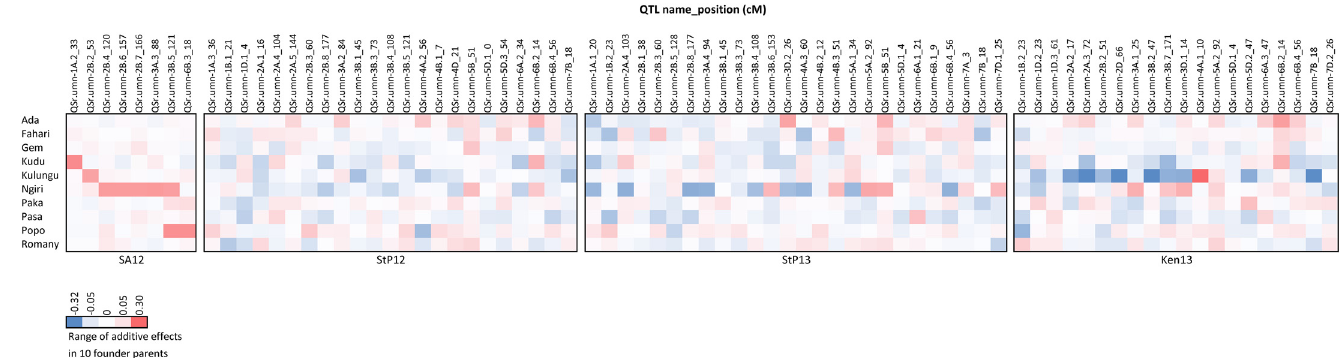
Fig 5. Heat map of additive effect estimates of alleles contributed by the 10 founder lines at the QTL for resistance to Pgt races. QTL (columns) are named according to McIntosh et al. [89] with their chromosomal positions after the underscore (_) symbol. The allelic effect estimates for each founder allele (rows) are color coded by increments in the allelic effect estimate (legend). Each block represents the environments where the QTL were detected, as